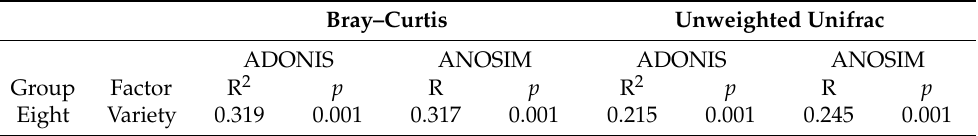
Table 3. The taxonomic metric (calculated from OTU) for bacterial diversity patterns. Bray–Curtis